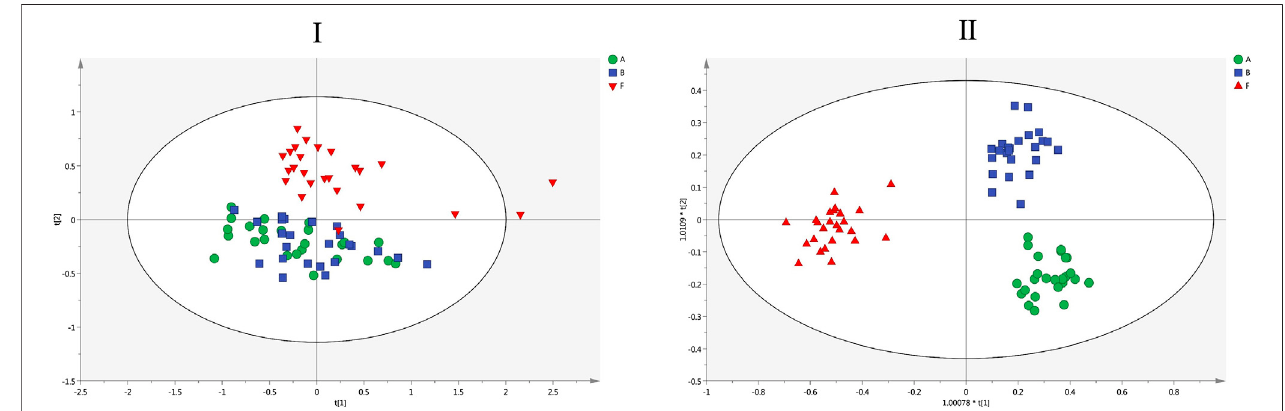
FIGURE 6 | The score plots of PCA (I) and OPLS-DA (II) models for the 202 targeted lipidomics analysis. I: R2X and Q2 values of the PCA model are 0.798 and 0.636,respectively;II:R2YandQ2valuesoftheOPLS-DAmodelare0.913and0.772,respectively.Greencircles,bluesquaresandredinverted trianglesdenotegroup control (A) , LPS (B) and LPS + H-HSW (F) , respectively.